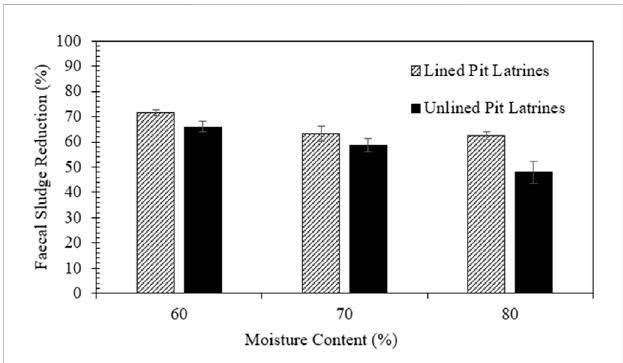
FIGURE 3 Faecal sludge reduction (FSR) ar different moisture content of both lined and unlined pit